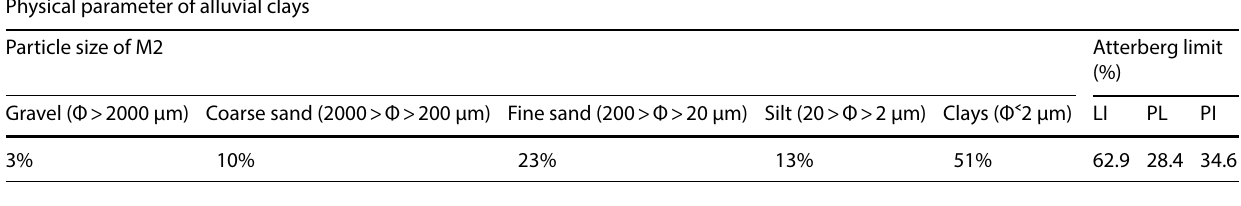
Table 1 Physical composition of raw alluvial material Physical parameter of alluvial clays Particle size of M2 Atterberg limit